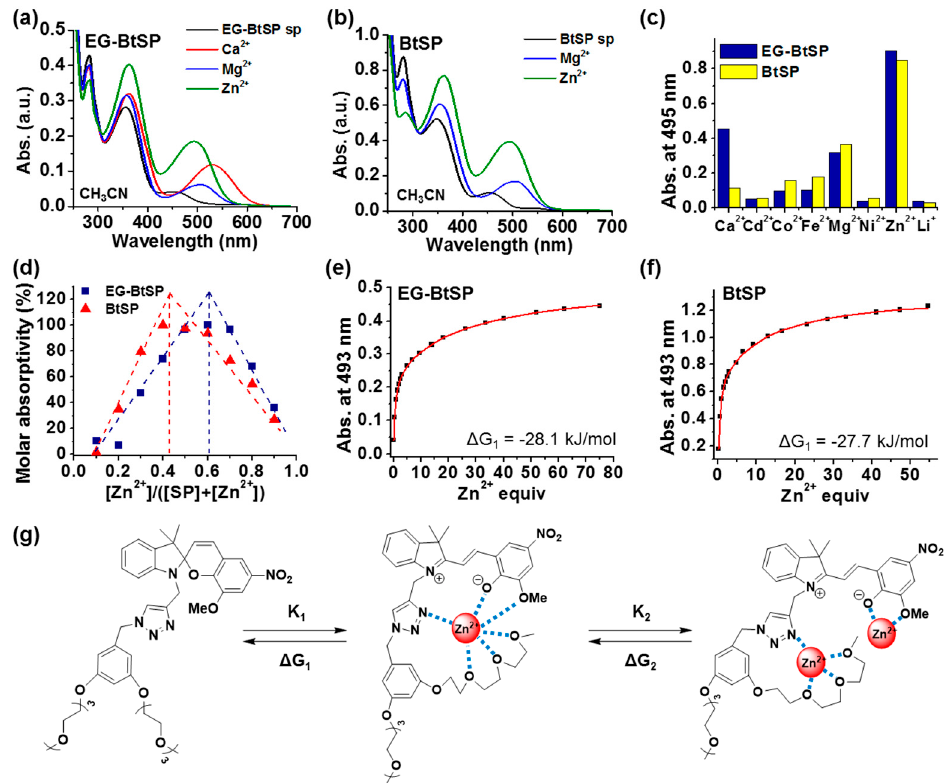
Figure 1. ( a , b ) Absorption spectra of EG-BtSP (a, 5 × 10 − 5 M) and BtSP (b, 1 × 10 − 4 M) after addition of 1.0 equiv. of Ca 2+ , Ma 2+ , Zn 2+ , and Ma 2+ , Zn 2+ metal perchlorates in CH 3 CN at 293 K, respectively; ( c ) Comparison of the absorbance at 495 nm of EG-BtSP and BtSP normalized